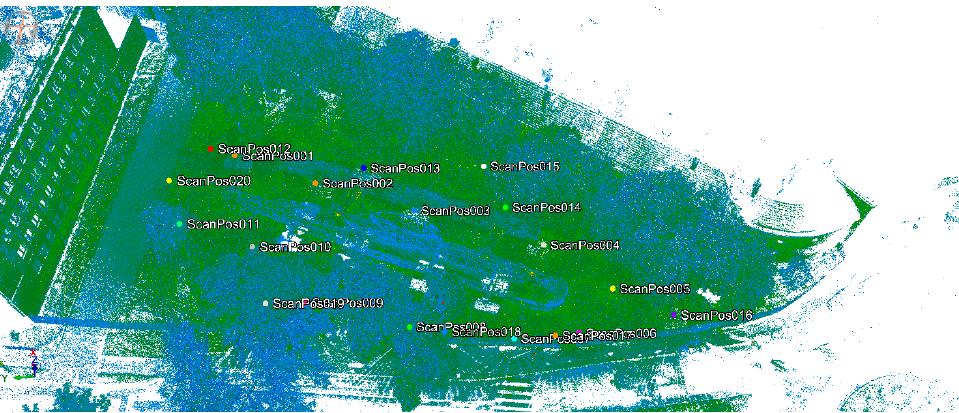
Figure 5. Scan positions during data acquisition.